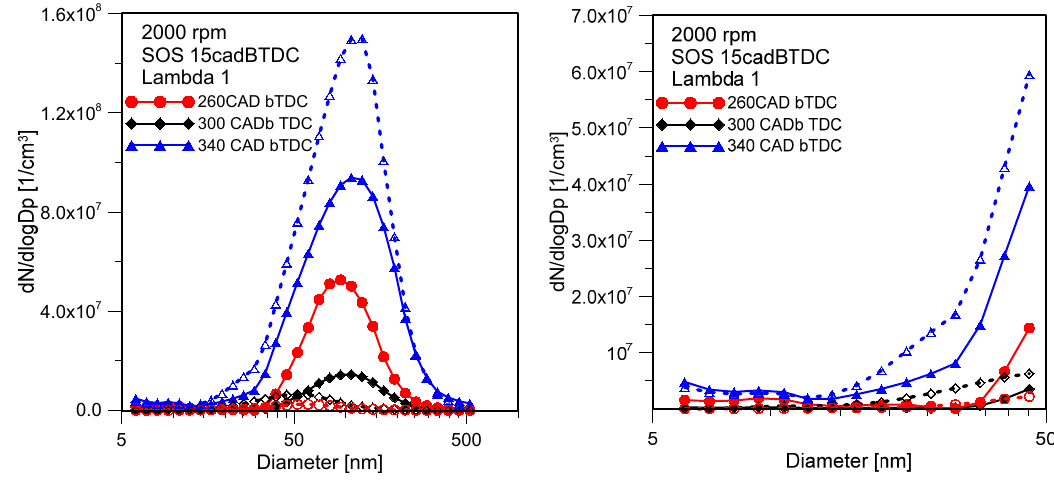
Figure 7. Particle size distribution measured at the exhaust at different SOI for gasoline (solid line) and butanol (dotted line).